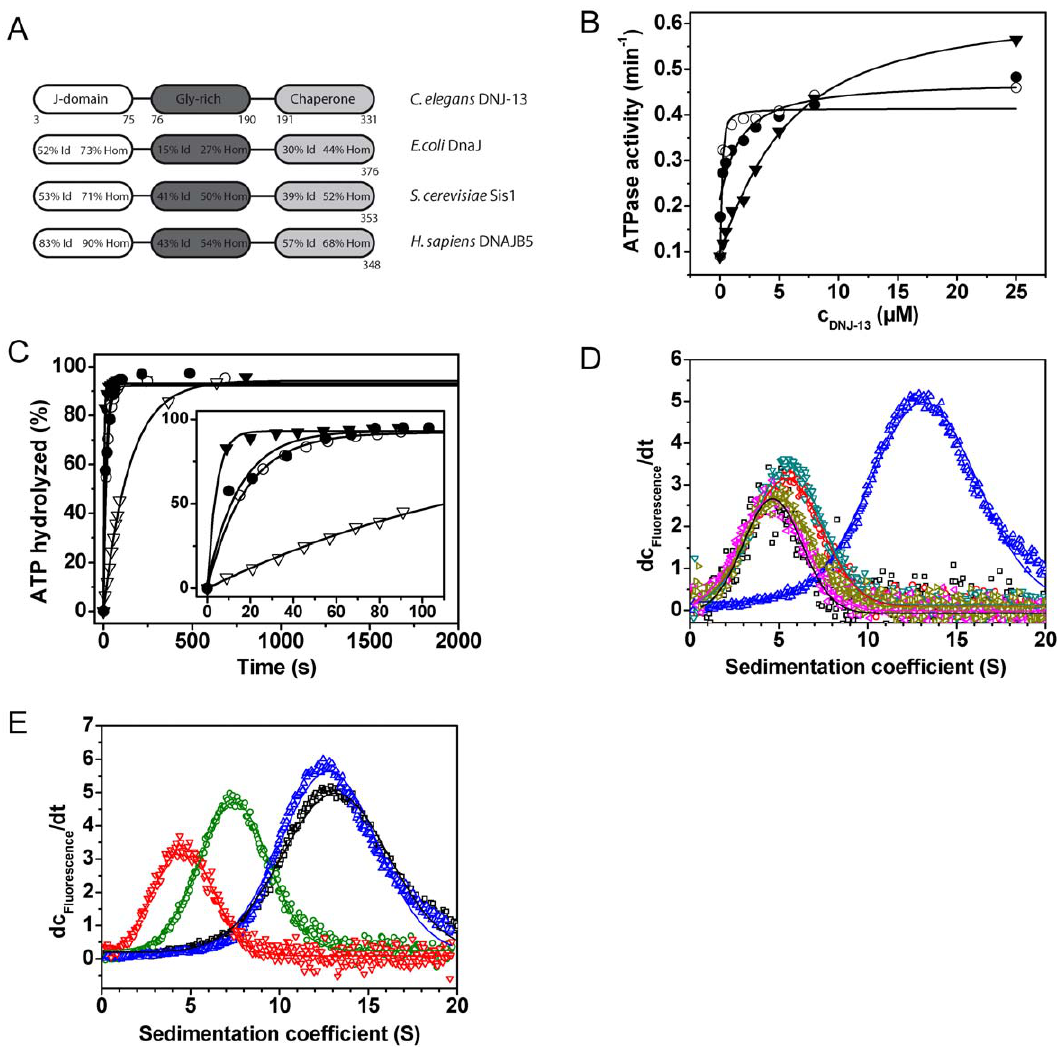
Figure 4. DNJ-13 interacts with CeHsc70 in presence of ATP and is released by BAG-1. ( A ) Domain organization of DNJ-13 homologs from N C. elegans , E. coli , S. cerevisiae and H. sapiens . Percentages relate to identical (Id) and homolog (Hom) residues in respect to the nematode protein. ( B ) ), CeHsc70- D 512 ( # ) or Steady-state ATPase activities were measured in the presence of increasing amounts of DNJ-13 for either CeHsc70 ( N CeHsc70- D 545 ( . ). Data were analyzed as described in the Materials and Methods section. ( C ) Single-turnover measurements of 10 m M CeHsc70- D 384 ( = ), CeHsc70- D 512 ( # ), CeHsc70- D 545 ( . ) and CeHsc70 ( ) in the presence of 15 m M DNJ-13. All data points were fit to single exponential functions. ( D ) dc/dt plots were generated from sedimentation velocity experiments of 300 nM *DNJ-13 in the absence (black) or in the presence of 3 m M CeHsc70 (pink). The influence of nucleotides was analyzed by addition of 4 mM of either ADP (gold), AMP-PNP (red), ATP c S (turqoise) or ATP (blue) to 300 nM *DNJ-13 and 3 m M CeHsc70. ( E ) dc/dt profiles of sedimentation velocity experiments of 300 nM *DNJ-13 in the presence of either 3 m M CeHsc70 (blue), CeHsc70- D 384 (red), CeHsc70- D 512 (black) or CeHsc70- D 545 (green) in the presence of ATP. doi:10.1371/journal.pone.0033980.g004 (Figure 5B). Only for CeHsc70- D 512 N BAG-1 complexes, a saturation curve could be observed (K D,app =1.2 m M 6 0.4 m M),